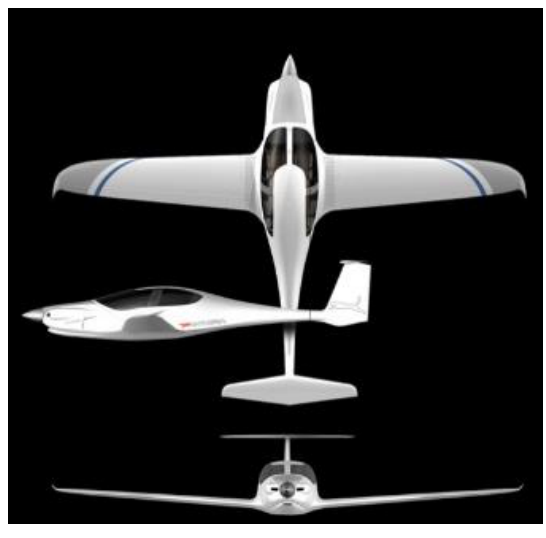
Fig. 4. Pipistrel Panthera aircraft [35]